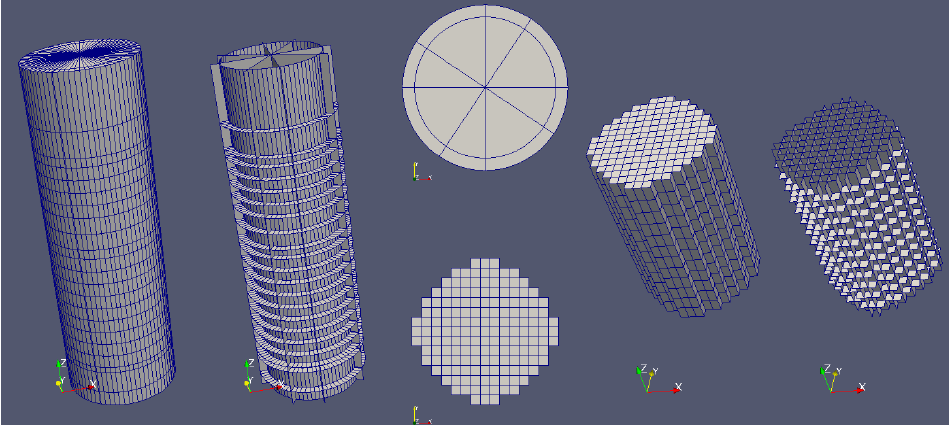
Figure 6. The meshes of the CY-V and CA-V (from left to right, from top to bottom: 3D body mesh/3D surface mesh/2D mesh of CY-V, 2D mesh/3D body mesh/3D surface mesh of CA-V).